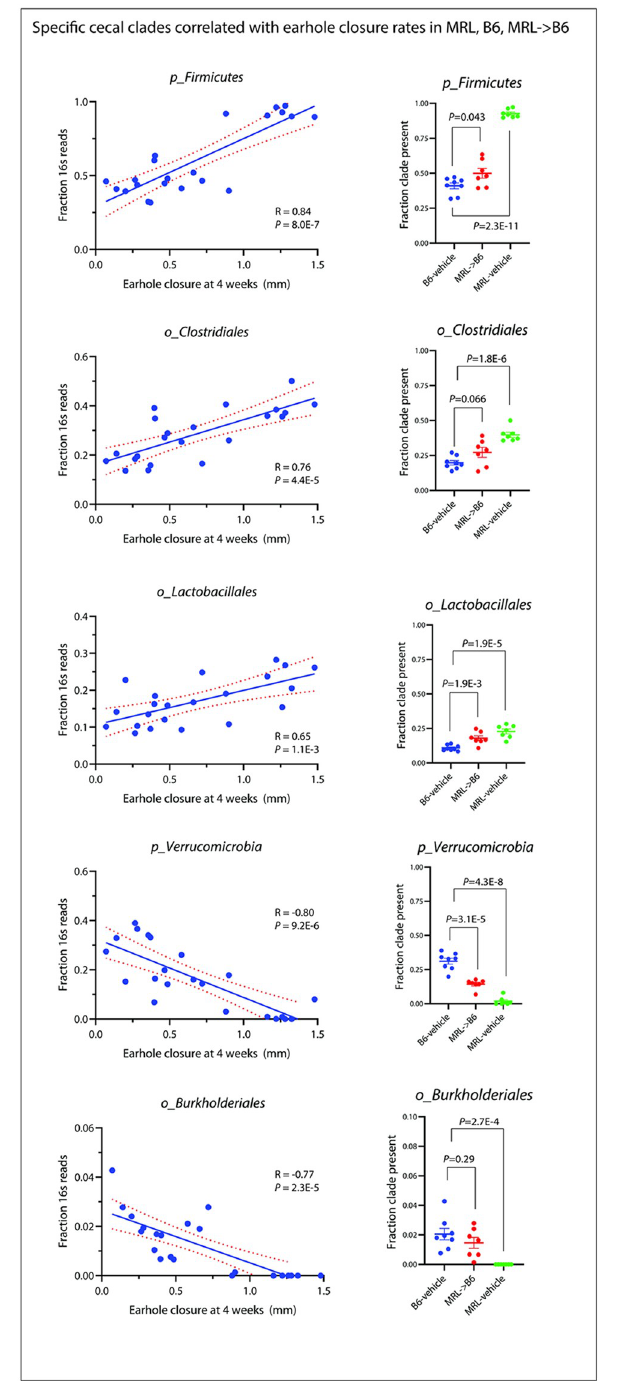
Fig 4. Cecal microbiome correlations with earhole